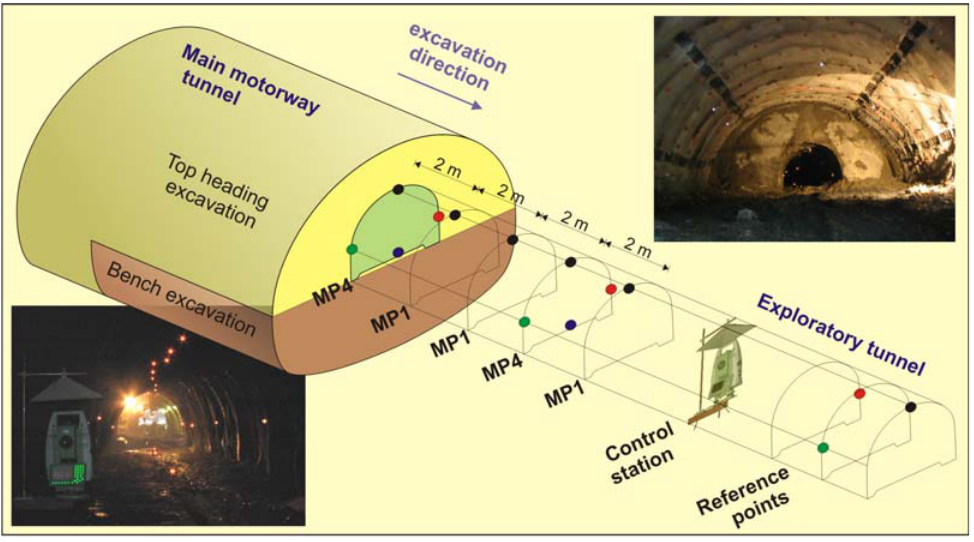
Figure 3. Scheme of the